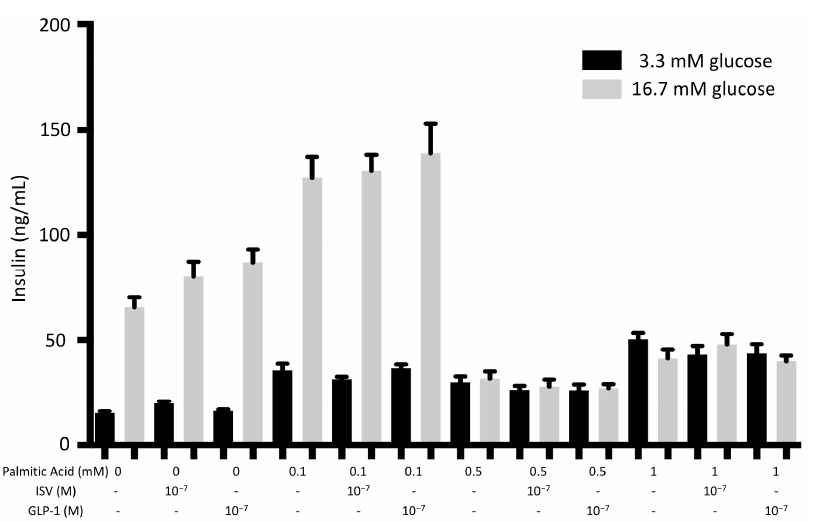
Figure 6. Effects of 10 − 7 M ISV and 10 − 7 M GLP-1 on insulin secretion in palmitic acid-treated INS-1E cells. After 72 h of incubation with or without 10 − 7 M ISV and 10 − 7 M GLP-1, in the medium containing 0.1 mM, 0.5 mM, or 1mM palmitic acid, cells were stimulated at low (3.3 mM) and high glucose (16.7 mM) for 1 h. Subsequently, insulin secretion was measured. Data are presented as the mean ± SEM of 18 samples per group from three independent experiments. The vehicle of 0 mM palmitic acid is equivalent to that of 0.5 mM palmitic acid.